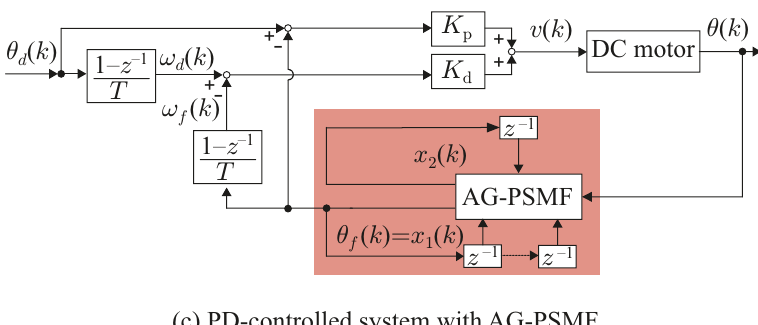
Figure 12. Block diagrams of PD-controlled systems. ( a ) without filter; ( b ) with PSMF; and ( c ) with